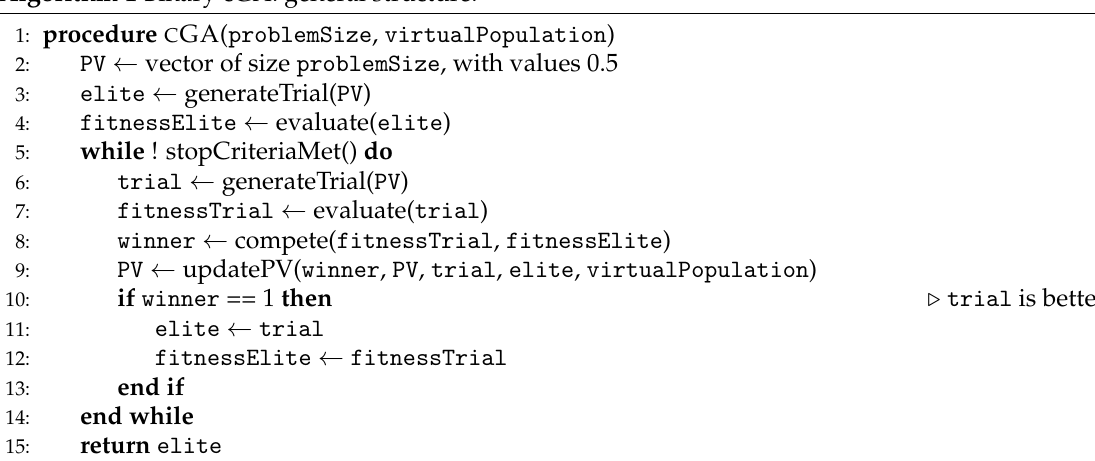
Algorithm 1 Binary cGA: general